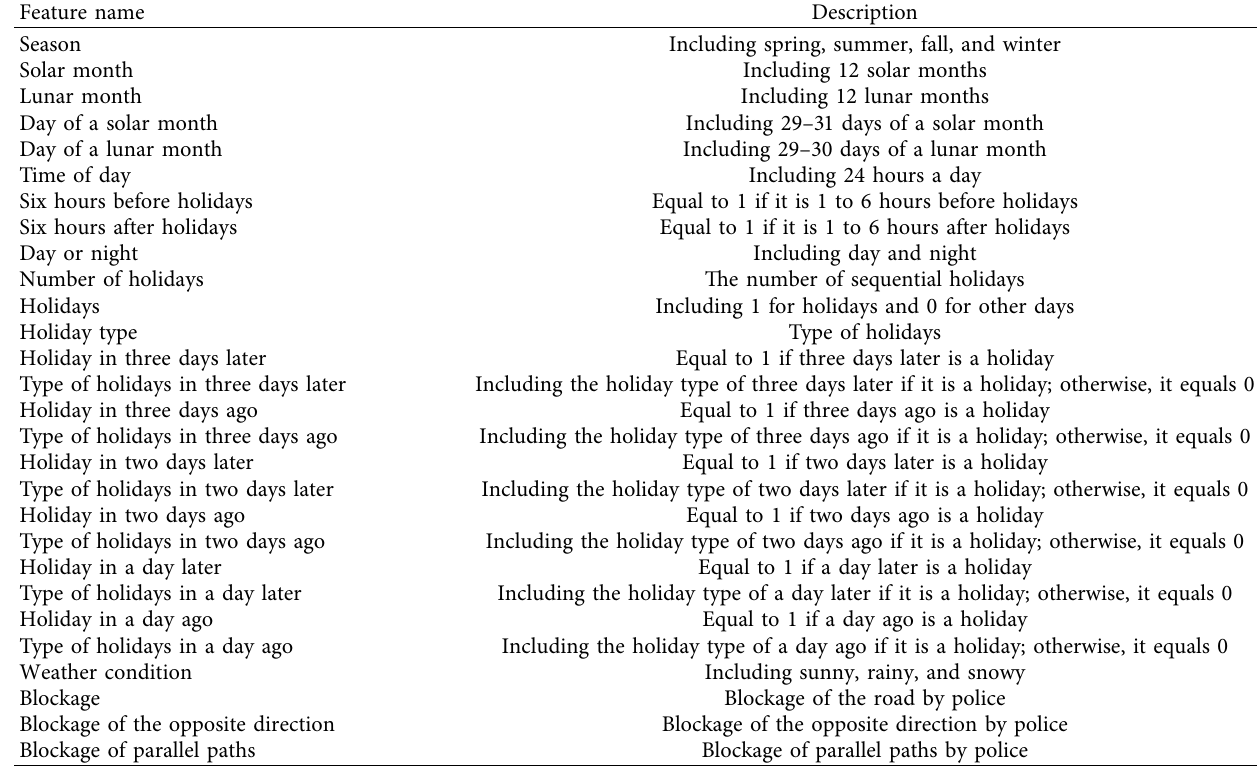
Table 2: Description of extracted candidate features to predict traffic state.